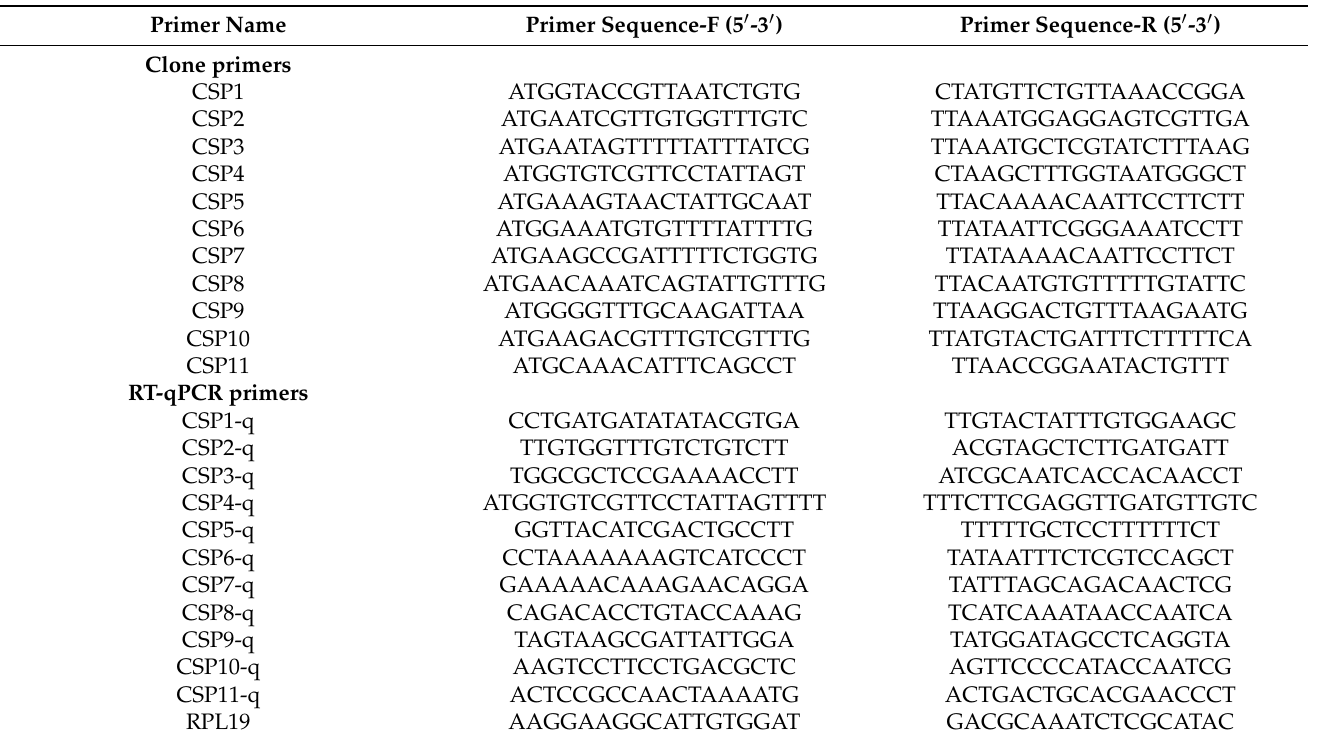
Table 1. List of designed primers for polymerase chain reaction (PCR) and quantitative